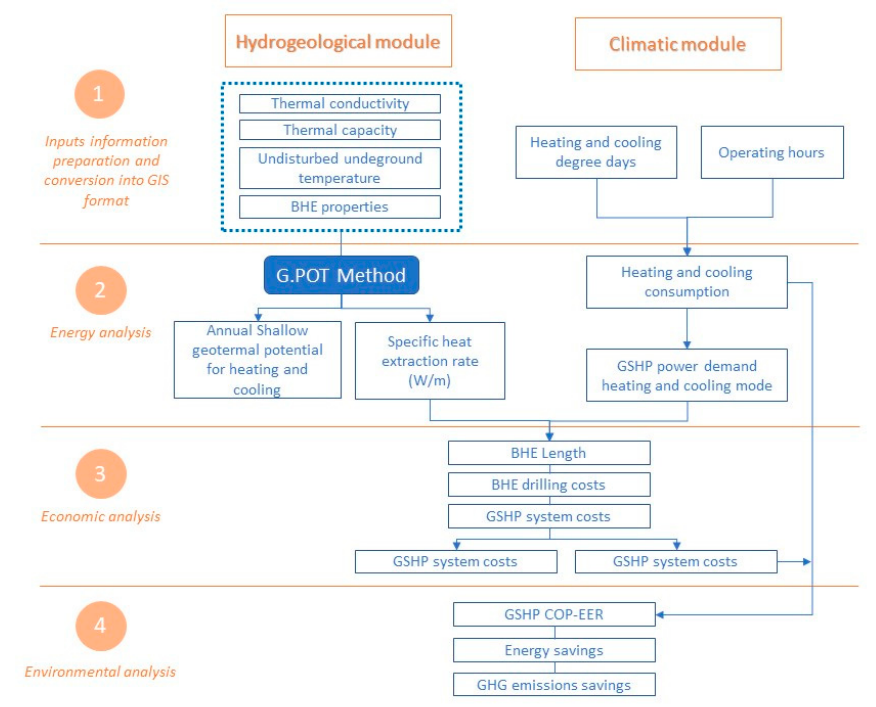
Figure 1. GIS-based top-down methodology workflow.